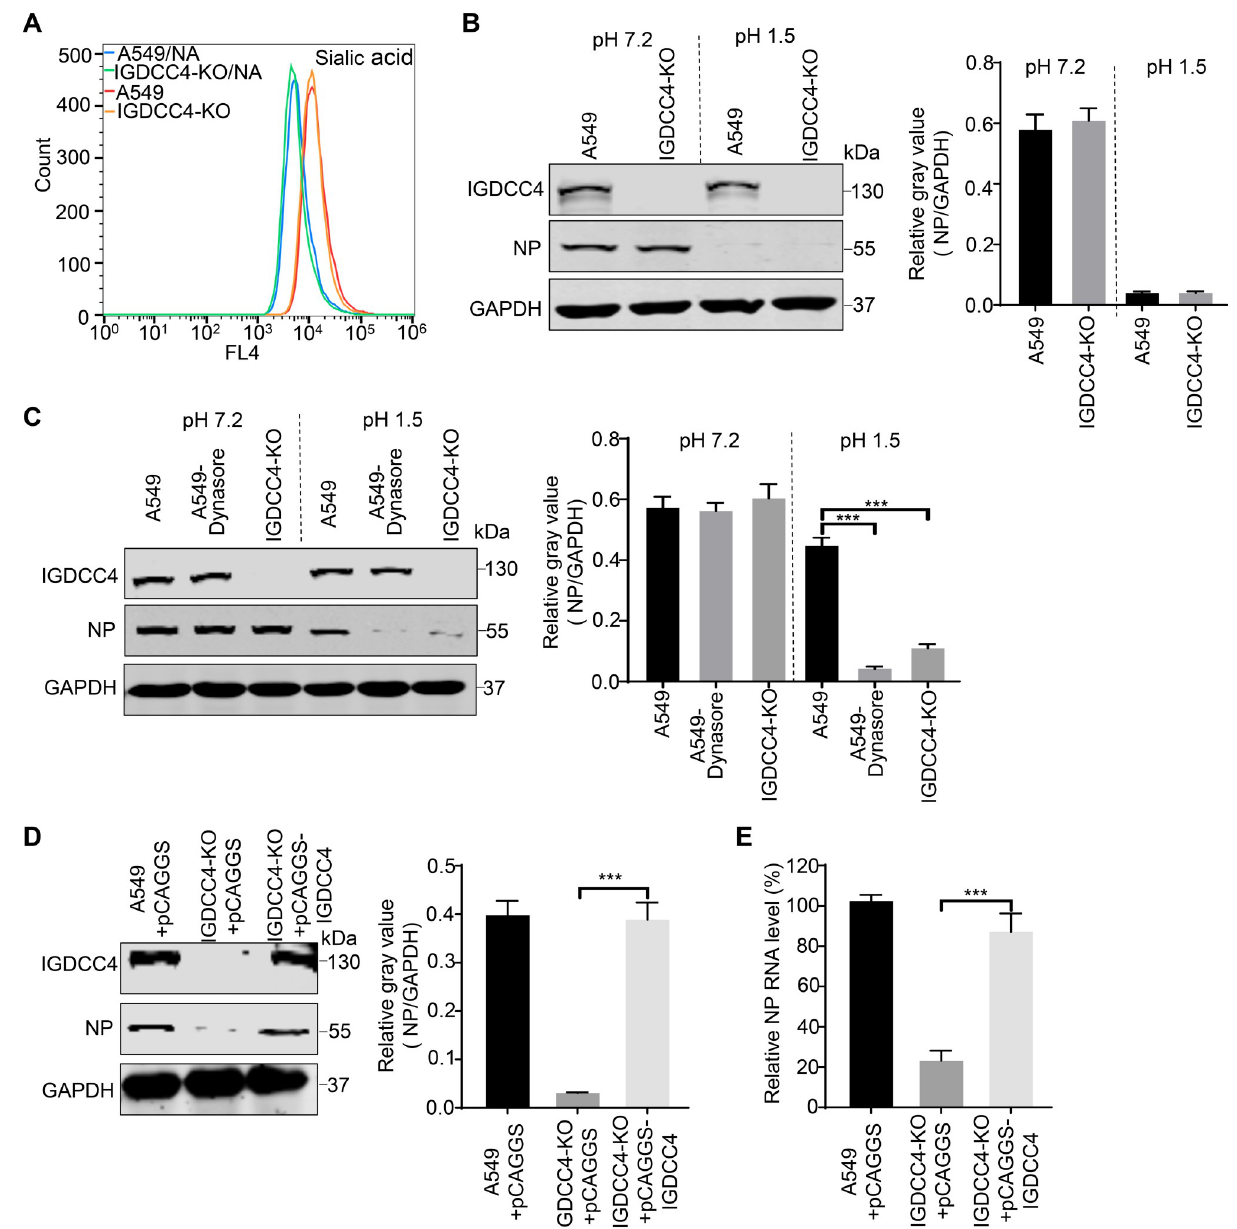
Fig 4. IGDCC4 is required for influenza virus internalization. ( A ) Sialic acid expression in different cells. IGDCC4-KO and A549 control cells treated with or without neuraminidase (NA) were stained with Alexa Fluor 647 conjugated with wheat germ agglutinin, and after three washes with PBS, the cells were suspended to detect WGA binding by use of flow cytometry. ( B ) NP protein of viruses attached to the surface of IGDCC4-KO and A549 cells. IGDCC4-KO and A549 cells were incubated with H5N1 virus at an MOI of 5 at 4˚C for 1 h and then washed with cold PBS (pH = 7.2) or cold acidic PBS (pH = 1.5), which can elute virus particles on the cell surface that have not been internalized. The cells were collected and the NP protein of the viruses attached to the cells was evaluated by Western blotting. ( C ) NP protein of viruses internalized into IGDCC4-KO and A549 cells. A549 cells treated with or without dynasore and IGDCC4-KO cells were incubated with H5N1 virus at an MOI of 5 at 4˚C for 1 h and at 37˚C for 1 h. After being washed with cold PBS (pH = 7.2) or acidic PBS (pH = 1.5), the cells were collected and the NP protein level of the total attached and internalized viruses (normal PBS washed) or the internalized viruses (acidic PBS washed) was determined by using Western blotting. ( D ) Overexpression of IGDCC4 restores the internalization of influenza virus into IGDCC4-KO cells. A549 cells and IGDCC4-KO cells transfected with the indicated plasmids were infected with H5N1 virus at an MOI of 5. After being incubated at 4˚C for 1 h and 37˚C for 1 h, the cells were washed three times with ice-cold acidic PBS. The washed cells were then collected to detect the NP protein level by Western blotting, and ( E ) the RNA level by qRT-PCR. The band intensities of the Western blots from three assays were quantified by using ImageJ software, and the relative gray values of NP to GAPDH are presented. The data shown represent or are from three independent experiments or replicates (means ± SDs). The two-tailed unpaired t-test was used for the statistical analysis. ��� , p <